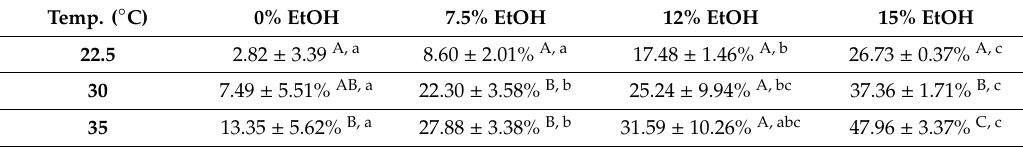
Table 1. Average percent of PA desorption (compared to initial adsorption at 15 ◦ C) and respective standard deviations as incubation temperature increased in distinct model wine solutions ( n =